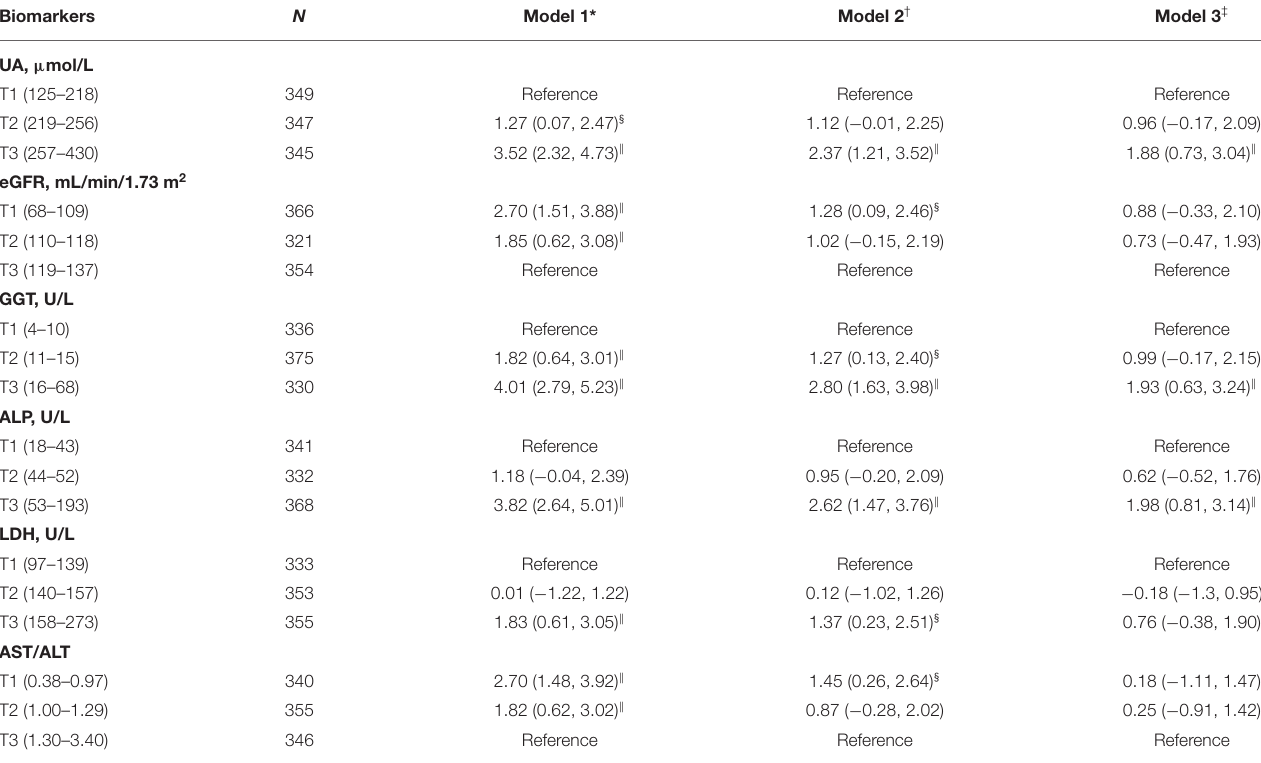
TABLE 3 | Longitudinal associations of early-pregnancy biomarkers levels with diastolic blood pressure levels during pregnancy.